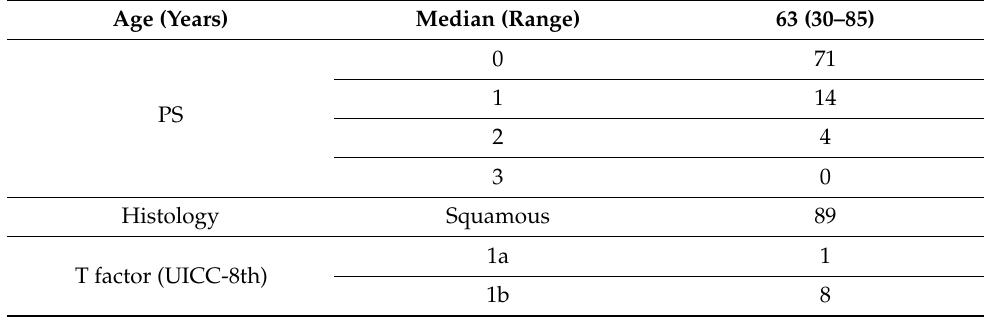
Table 1. Patient and tumor